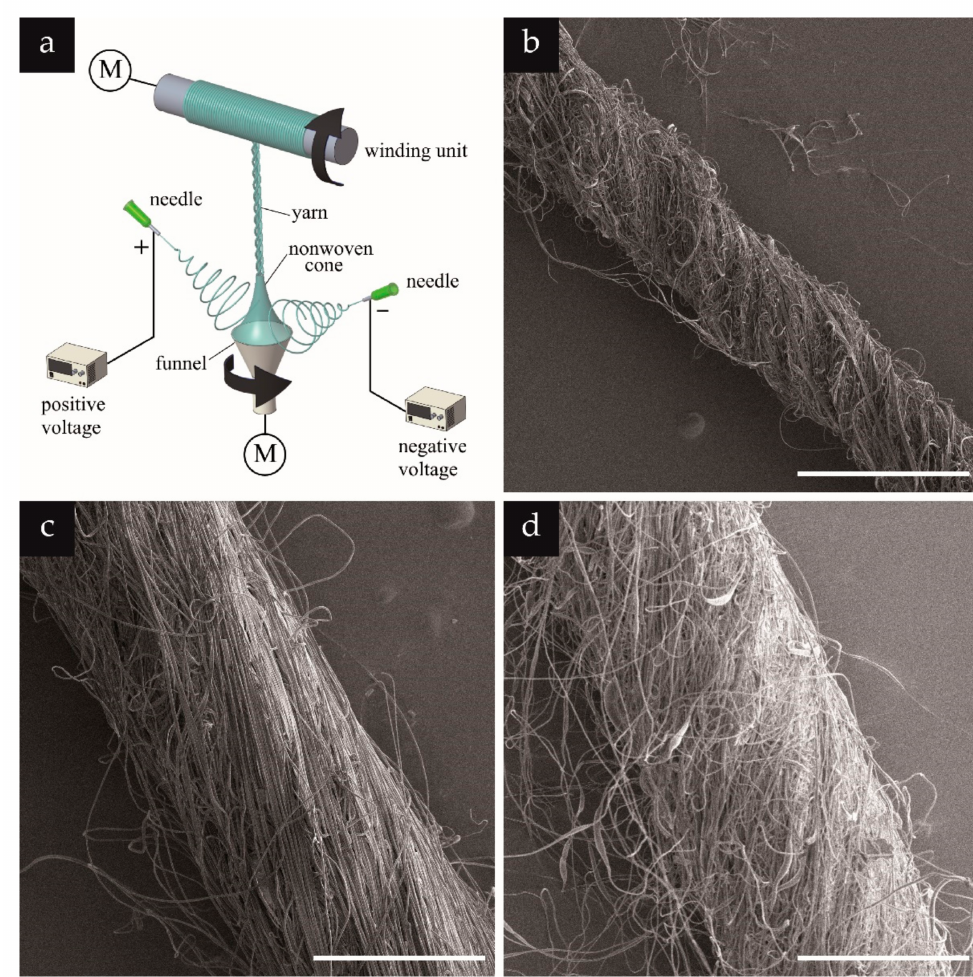
Figure 6. ( a ) Electrospinning setup based on Li et al.’s work with a slightly different arrangement: the funnel was vertical and the winding unit was positioned above the funnel. Two needles charged with opposite voltages were used, generating fibers that were twisted using the motorized rotating funnel, from which a yarn was drawn and collected using a motorized winding, allowing continuous electrospinning of biopolymer yarns. ( b – d ) SEM images of yarns with apparent twists electrospun out of recombinant spider silk eADF4(C16) ( b ), PAN ( c ), and cellulose acetate ( d ) solutions, respectively. Scale bars = 100 µ